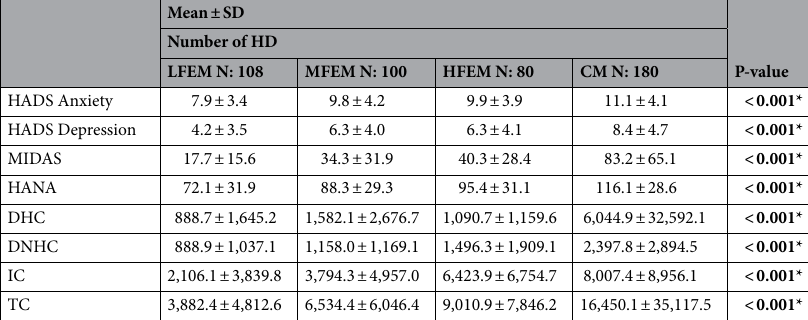
Table 3. Bivariate analysis between the number of HD and mental health, disability and cost. LFEM low- frequency episodic migraine; MFEM medium-frequency episodic migraine; HFEM high-frequency episodic